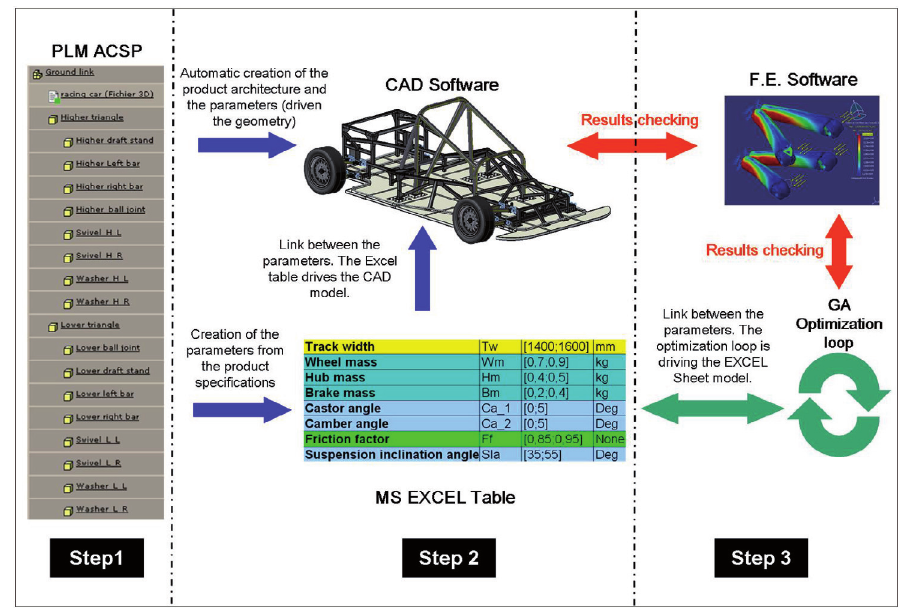
Fig. 1. Global methodology model for collaborative, functional and knowledge-based engineering using a PLM environment and integrating an optimization loop.